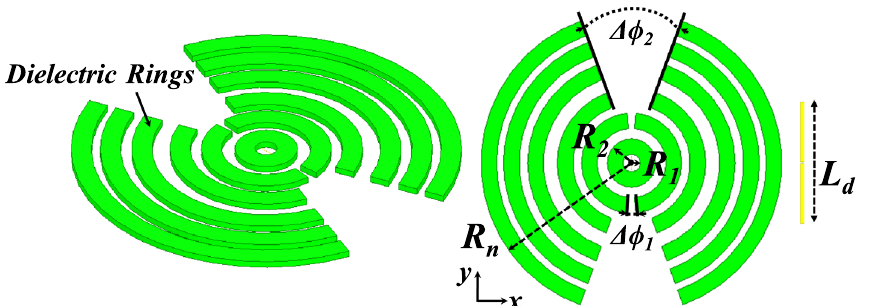
Figure 7. Electric current source in between dielectric slabs, semi-ring shape, right (top view), and left (isometric